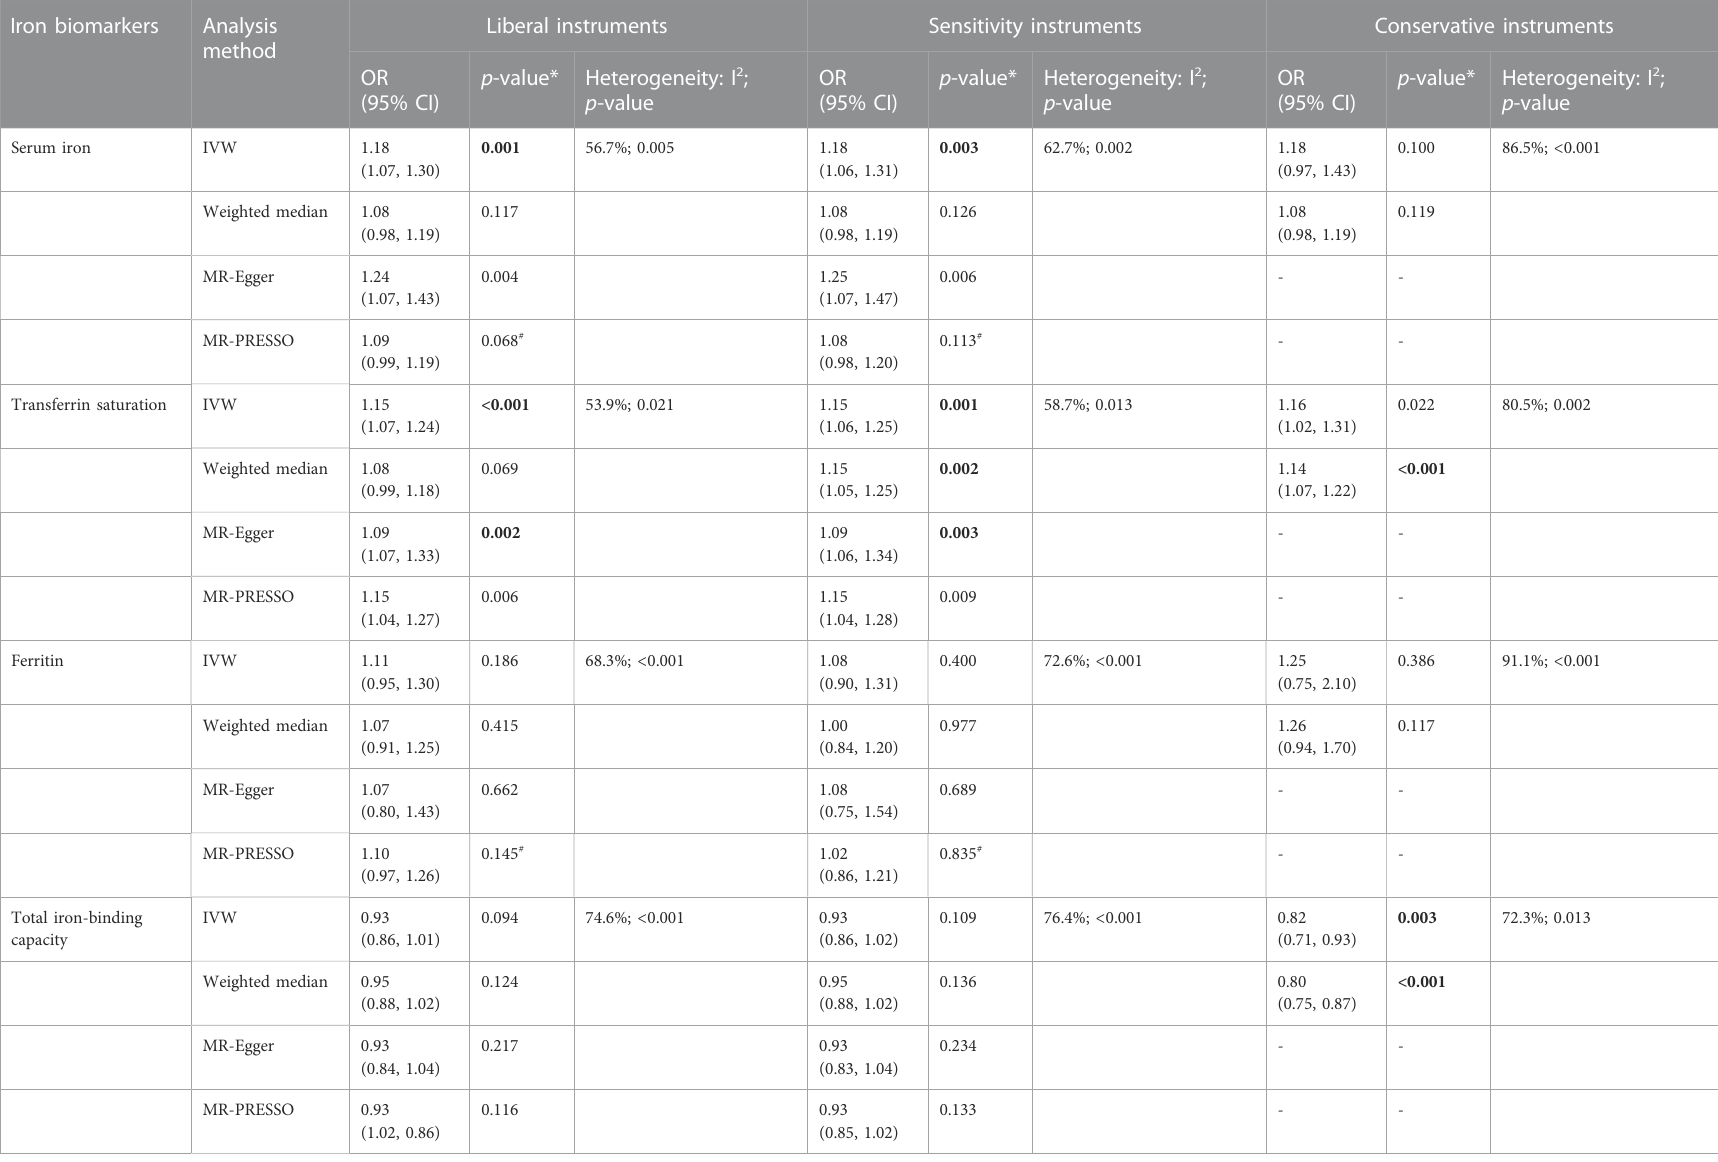
*Bolded p values indicate a value of < 0.003. #Presented with outlier-corrected value because the global test of the pleiotropy is signi fi cant ( p < 0.05). IVW, inverse variance weighted; MR-PRESSO, mendelian randomization pleiotropy residual sum and outlier; OR, odds ratio; CI, compatibility/con fi dence